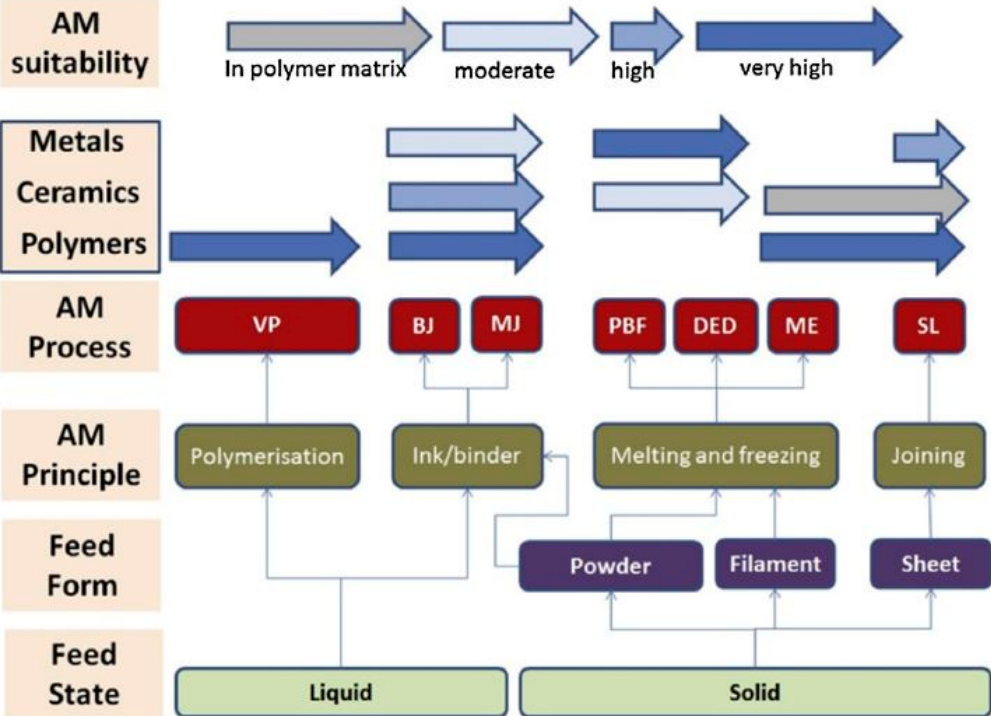
Figure 9. Schematic of the relative suitability of AM for three major types of materials (polymers, ceramics and metals) in various feed forms and states using ASTM processes: binder jetting (BJ); directed energy deposition (DED); material extrusion (ME); (4) material jetting (MJ); powder bed fusion (PBF); sheet lamination (SL); and vat photopolymerization (VP). Reproduced with permission from [154]. Copyright Elsevier, 2017.